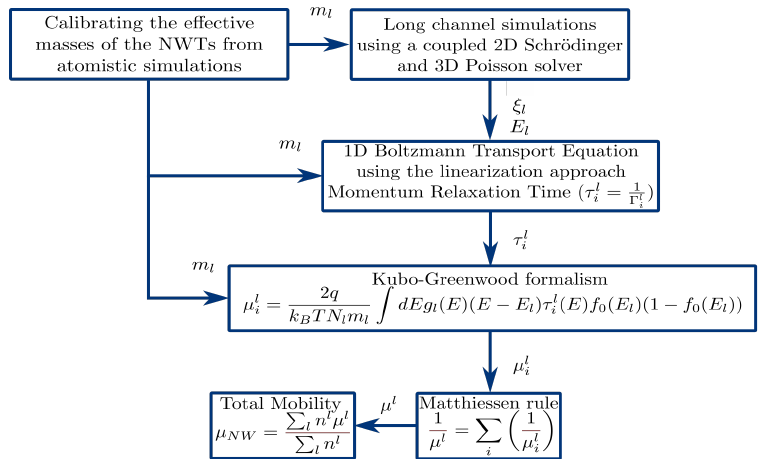
Figure 1. A flowchart illustrating the simulation framework and the corresponding steps needed to calculate the total mobility. l is the subband index; m l , ξ l , and E l are the calibrated effective masses, the wavefunction, and the energy level for the l th subband, respectively; i is the i -th scattering mechanism; τ l , Γ l , and µ l are the relaxation time, scattering rate, and mobility, respectively, for the i th i i i mechanism and l th subband; µ NW is the total mobility for a particular NW